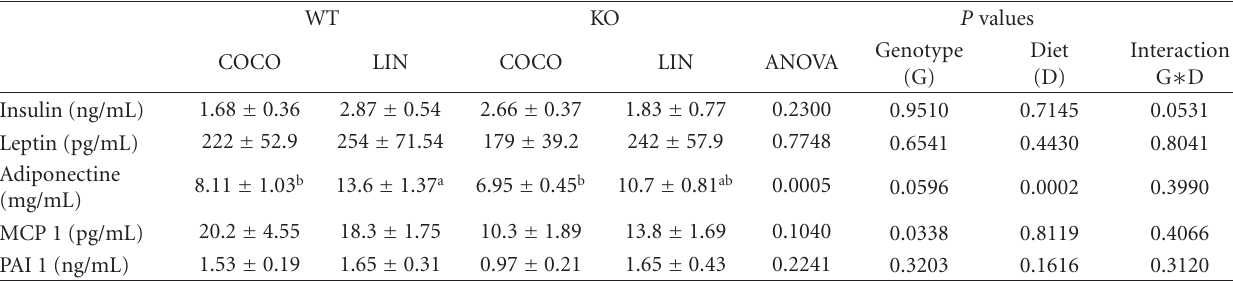
Table 6: Plasma hormones and cytokines concentrations in WT and PPAR α -null (KO) mice fed diets containing either saturated FA (COCO diet) or ALA (LIN diet) for 8 weeks.